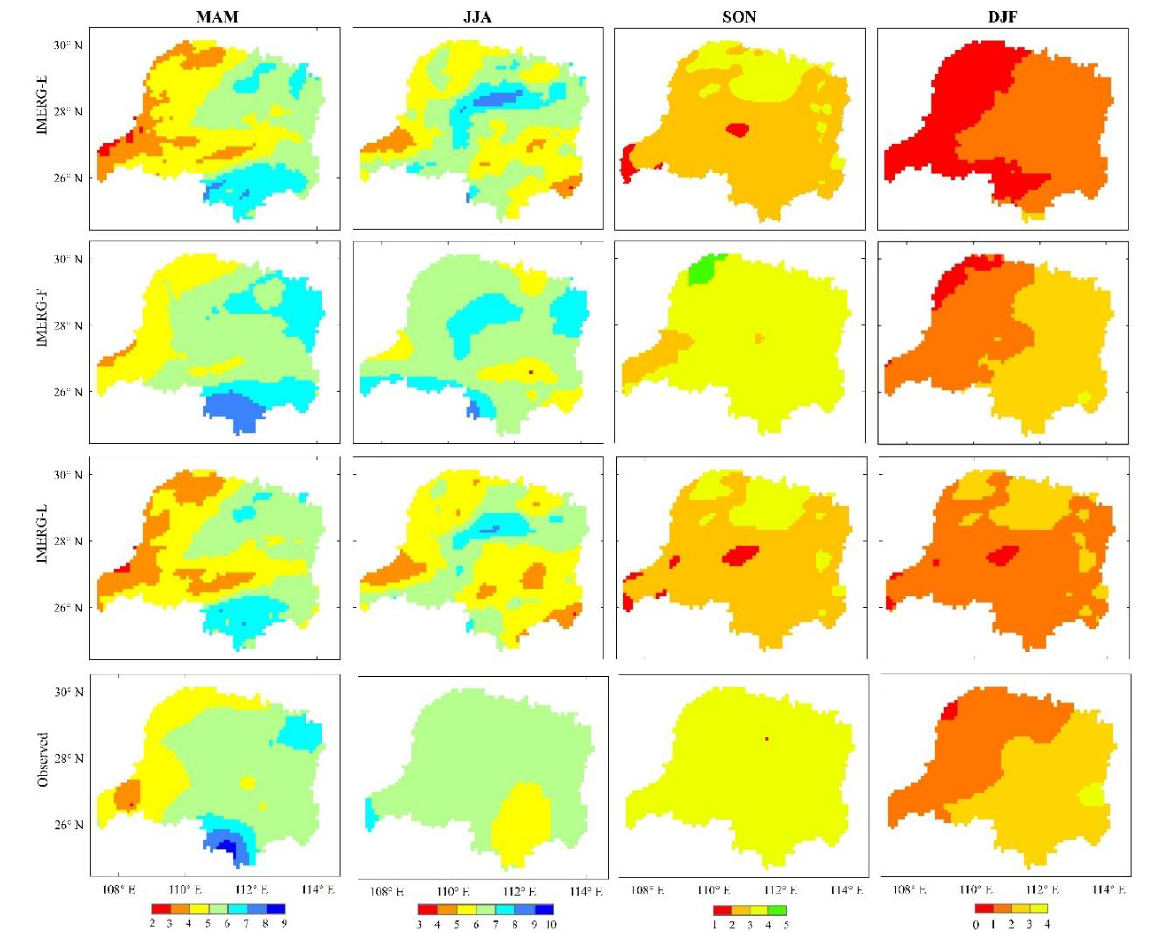
Figure 8. Seasonal mean precipitation (mm/day) distributions ranging from March 2015 to February 2021 derived from IMERG-E, IMERG-L, IMERG-F, and observed data from the Dongting Lake basin, China.